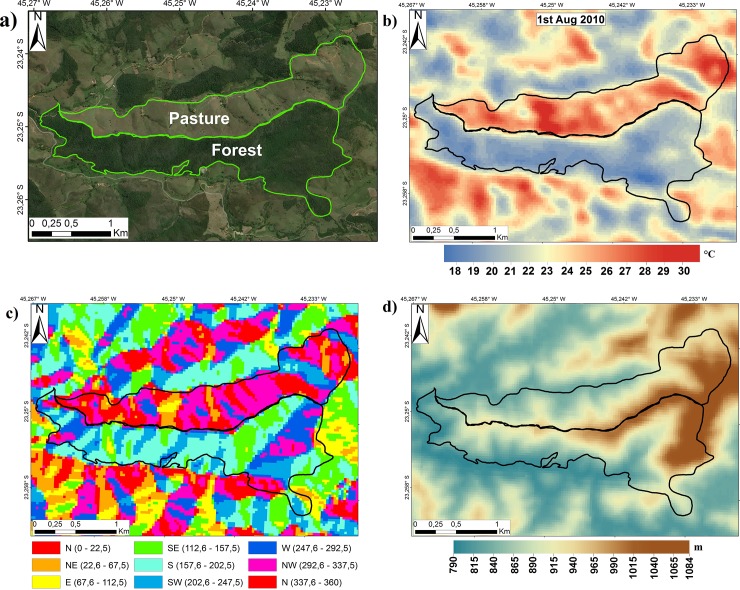
(a) Forest vegetation patch to the south of a pasture area (perimeters outlined in light green) (source: Microsoft Bing Maps Services) near Catuçaba district, São Luiz do Paraitinga, SP, with associated information of (b) LST (°C) (August 1, 2010), (c) aspect (°), and (d) altitude (m).